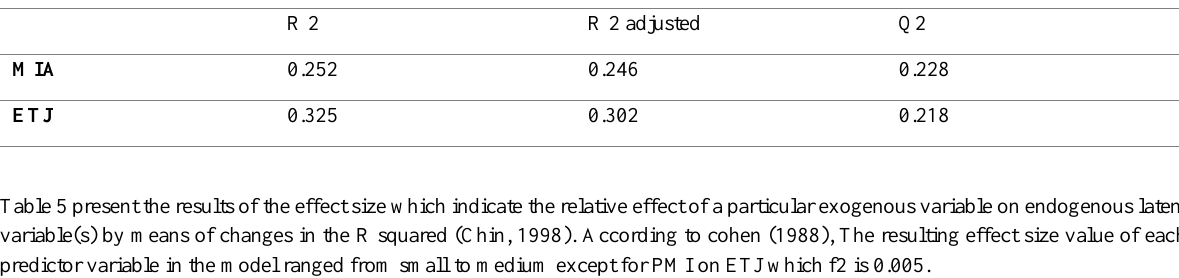
Table 4 : R square and predictive relevance